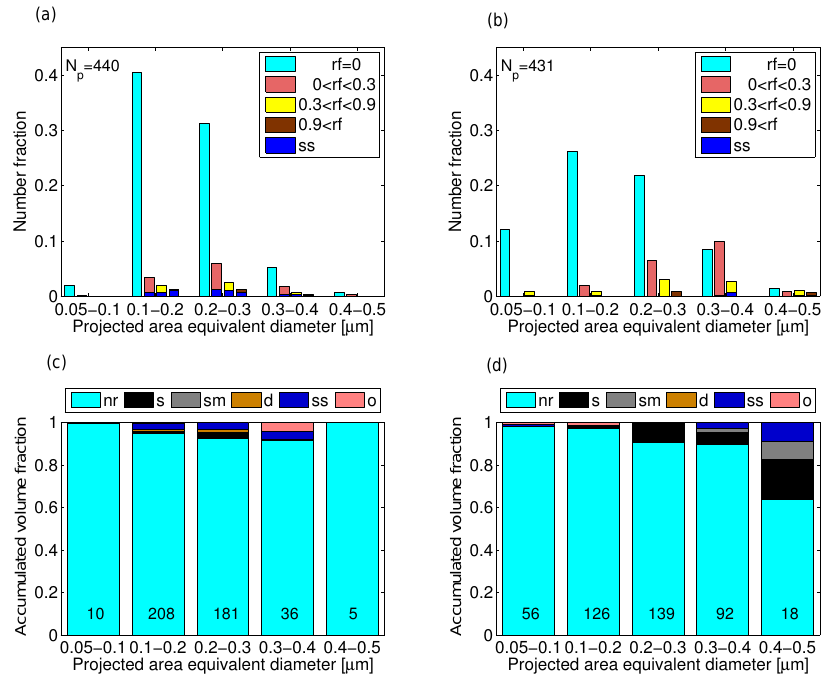
Figure 6. The classification of particles analysed with transmission electron microscopy; (a) and (b) represent two different periods of the campaign: the fraction of the total number of particles studied ( N p ) grouped according to the initial projected-area-equivalent diameter and the estimated refractory volume fraction (rf). Sea salt is shown separately in blue in all the volume fraction ranges. In (c) and (d) , the volume fractions of the different groups of substances are shown: non-refractory (nr), soot (s), soot mixtures (sm), dust (d), sea salt (ss) and the refractory substances not falling into any of these classes are classified as “other” (o) for the same time periods as in (a) and (b) respectively. The numbers included in the lower part of each bar are the total number of particles with an initial PAED in that size range. More details about the individual samples are given in Table 2.